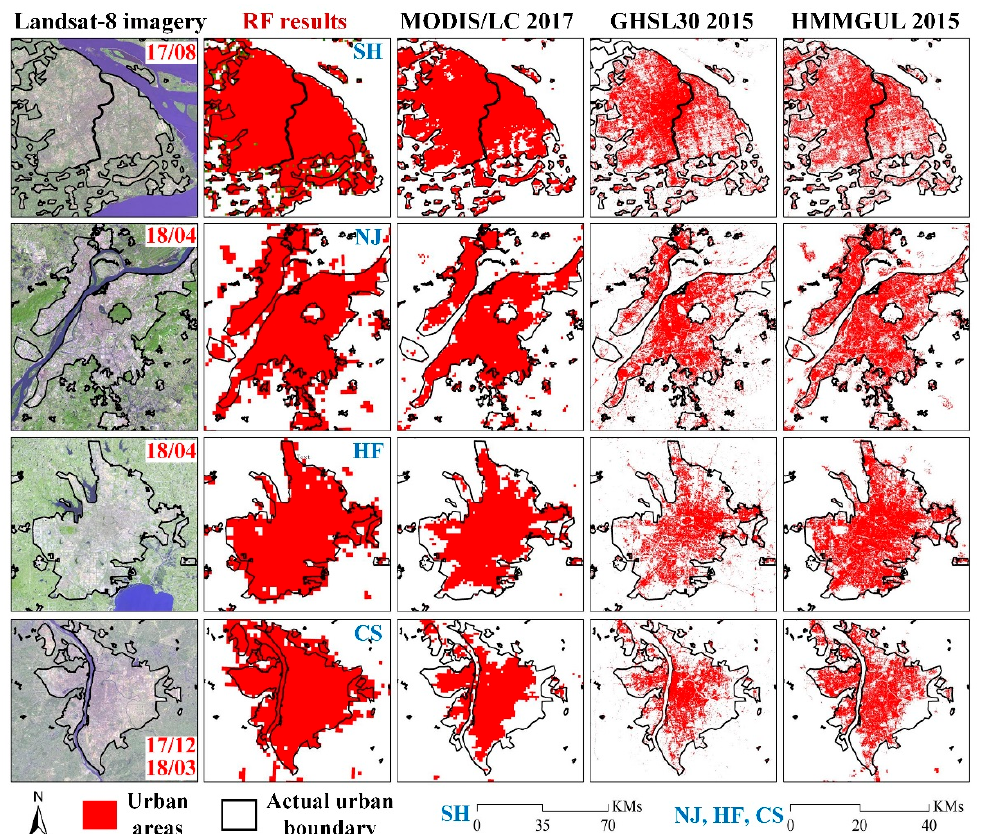
Figure 10. A comparison of the Landsat 8 imagery (SWIR2-SWIR1-Red), MODIS / LC 2017, GHSL30 2015, HMMGUL 2015, and RF classification results (urban probability > 0.5). The Landsat-8 images were acquired at di ff erent dates due to cloud cover (August 2017 for Shanghai (SH); April 2018 for Nanjing (NJ) and Hefei (HF); and a composite of images from December 2017 and March 2018 for Changsha (CS)). The actual urban boundary was acquired from the manual interpretation of Landsat-8 images and cadastral data from the local Land and Resource